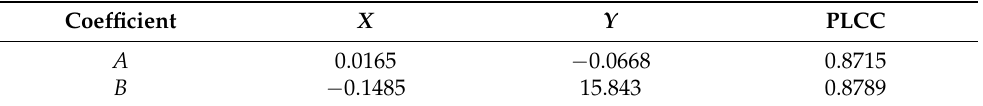
Table 4. Values of X and Y coefficients that resulted from fitting the values of A , B , and SITI . PLCC values present the correlation between the fitted curves and the measured values.